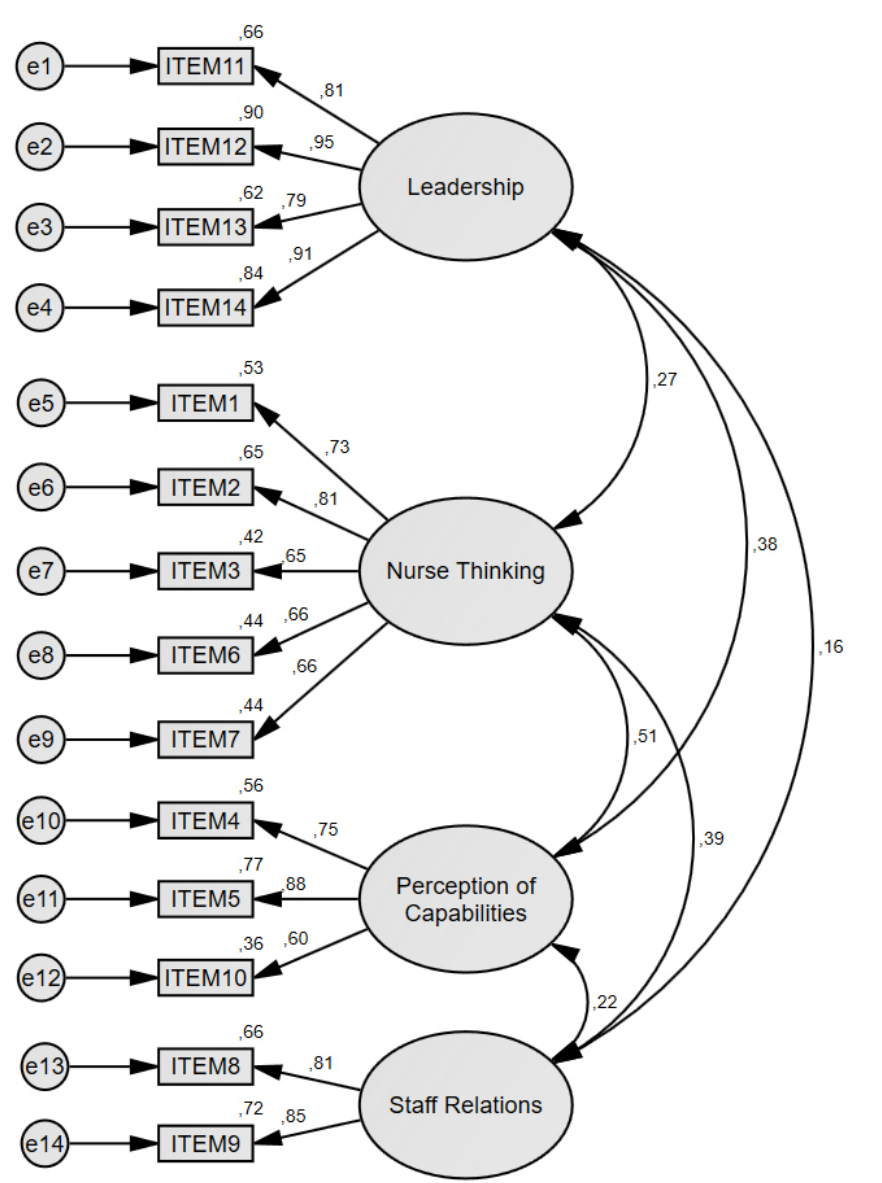
Figure 1. Four-factor model and item distribution for the NSCI-S. Table 4. Gender differences per group 1